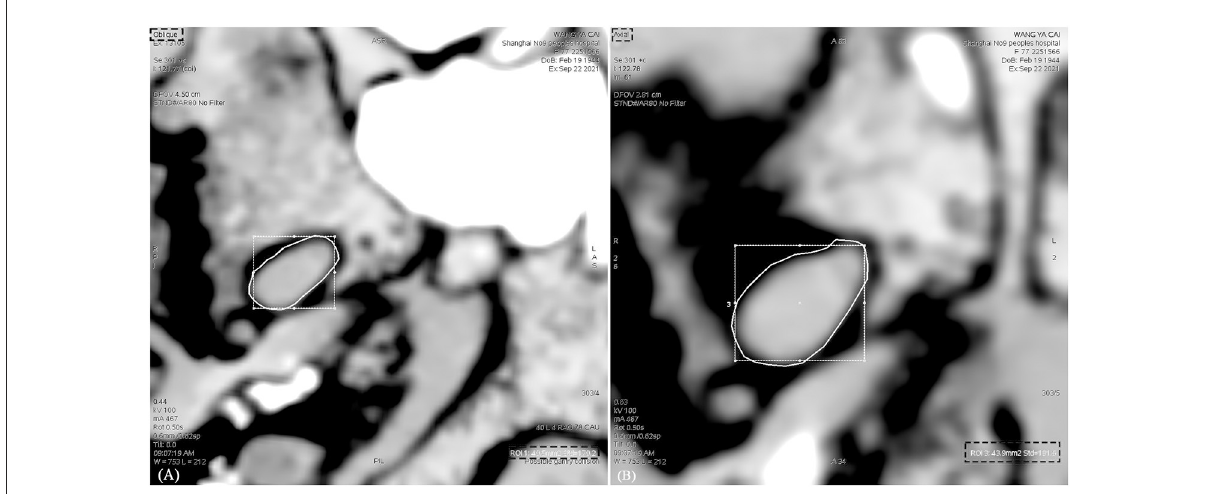
FIGURE2 Measurement of the area of the foramen ovale on CT images in different position. (A) The area of the foramen ovale was measured in the oblique position. (B) The area of the foramen ovale was measured in the axial position. The area measured in the axial position is greater than that in the oblique position.